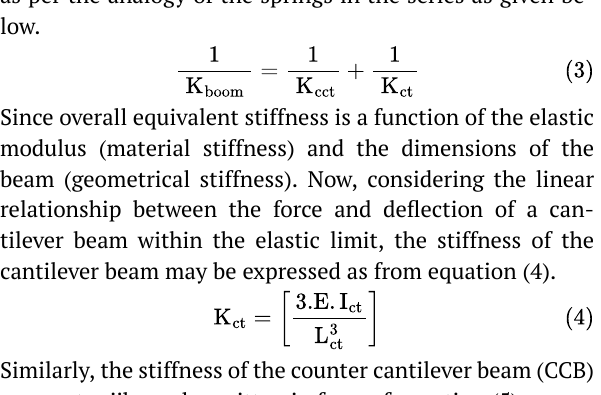
Figure 2. Boom and its equivalent diagram in form of cantilever beams cantilever and counter jib along with the weight of a mast in the form of a